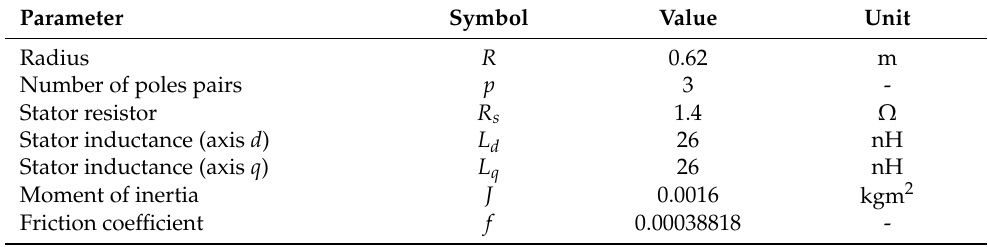
Table 1. WT and PMSG specifications.